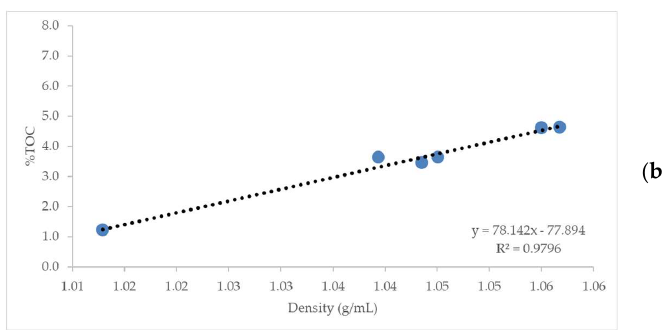
Figure 1. Correlation between Density and TOC. ( a ) October 2017; ( b ) June 2018.